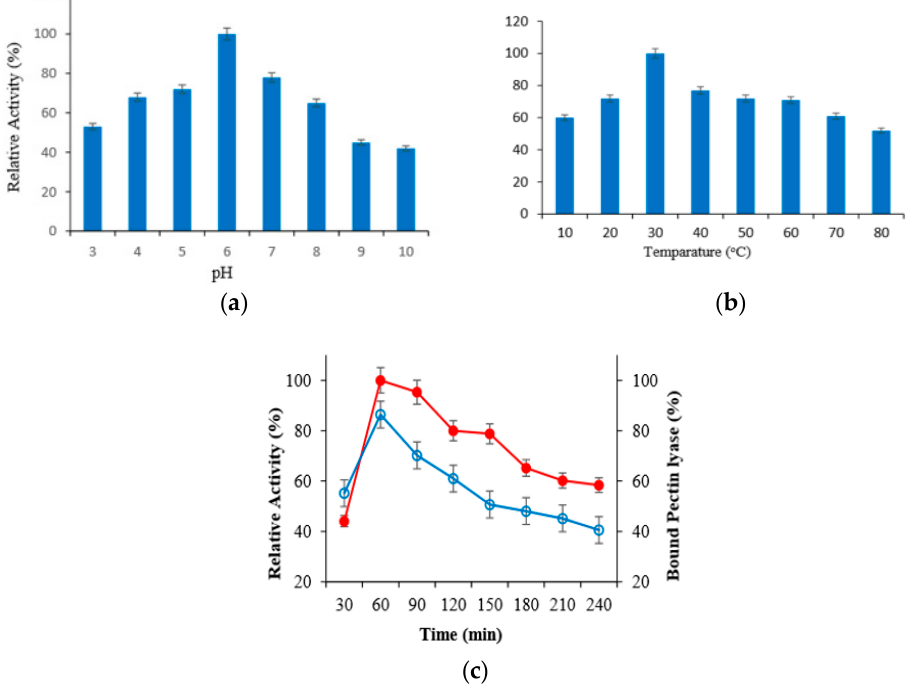
Figure 1. Results of the effect of pH ( a ), temperature ( b ) and incubation time ( c ) on immobilization of PL enzyme on N-MLf.